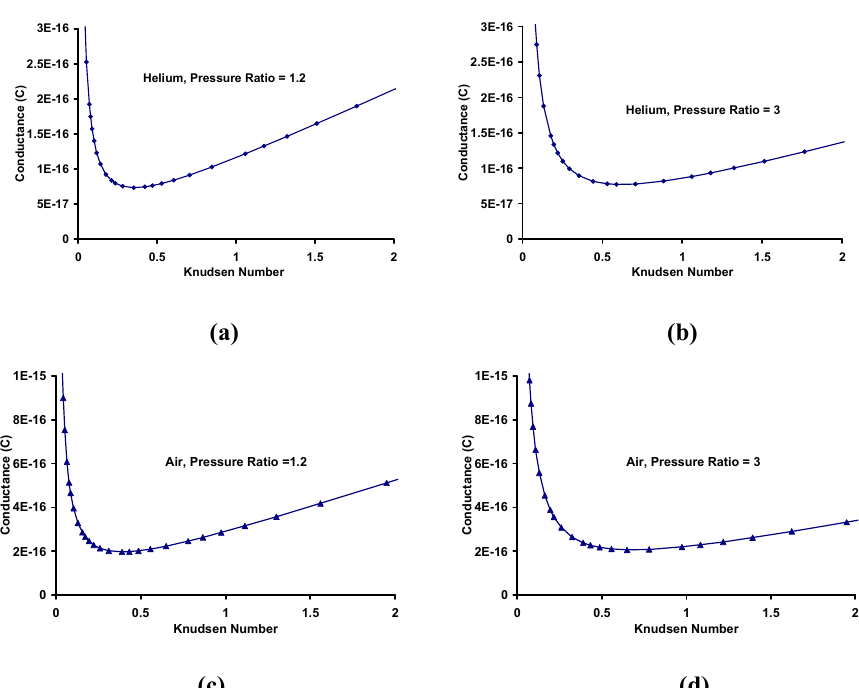
Fig. 10: Comparison of conductance versus Knudsen number for different gases at different pressure